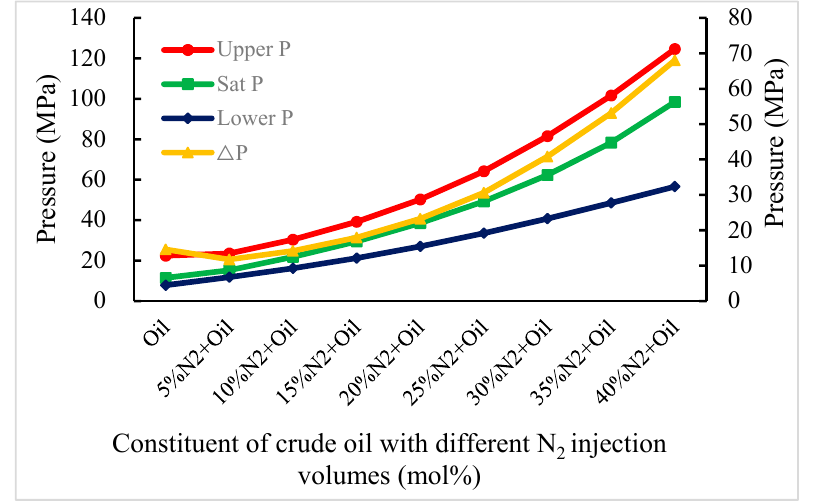
Figure 3. Asphaltene deposition pressure change with different injection volumes of N 2 at 65 ◦ C in a shallow reservoir.